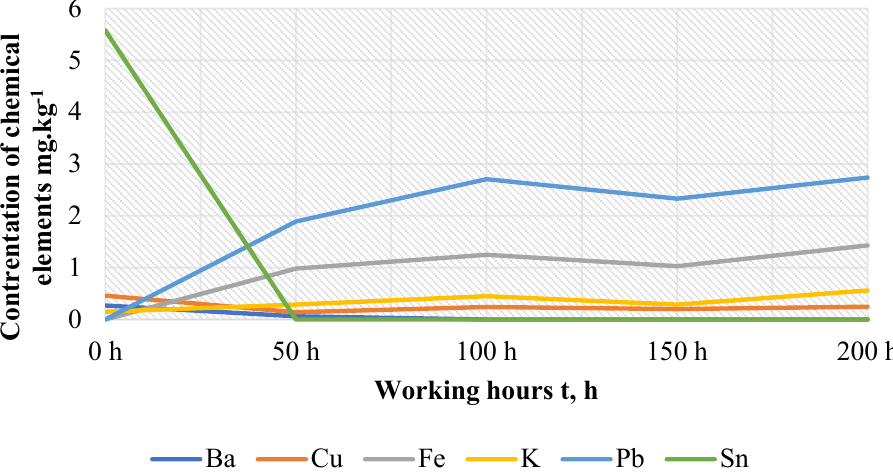
Figure 3. Graph of atomic emission spectrometry after 200 h from the point of view of contaminants. Ta ble 2. Atomic emission spectrometry from the point of view of contaminants.